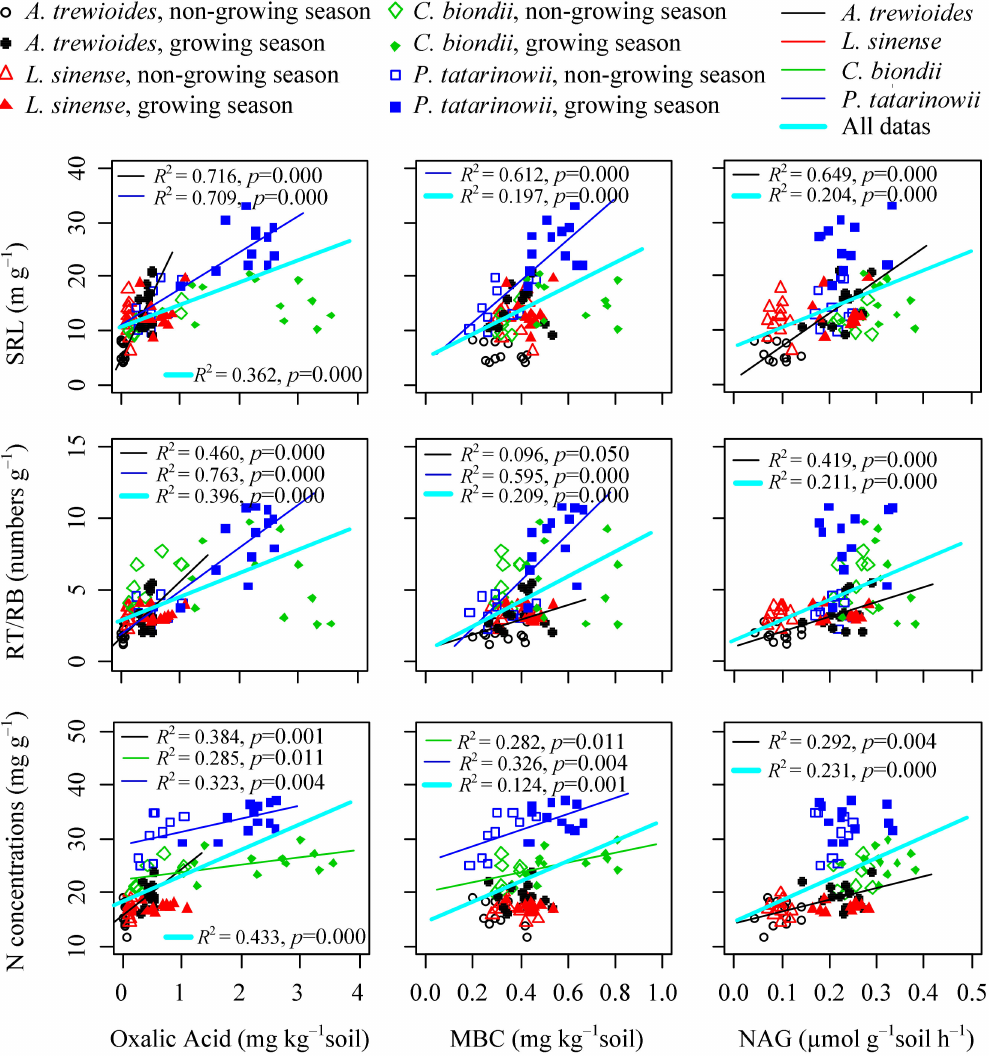
Figure 5. Relationships between fine root traits (SRL, RT/RB, and N concentration) and rhizosphere soil oxalic acid, microbial biomass carbon (MBC), and activity of a hydrolytic enzyme (NAG) in a karst ecosystem of southwest